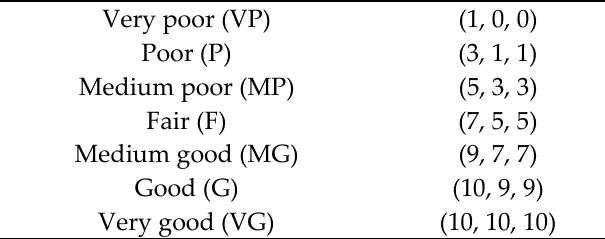
Table 3. Linguistic variables for the